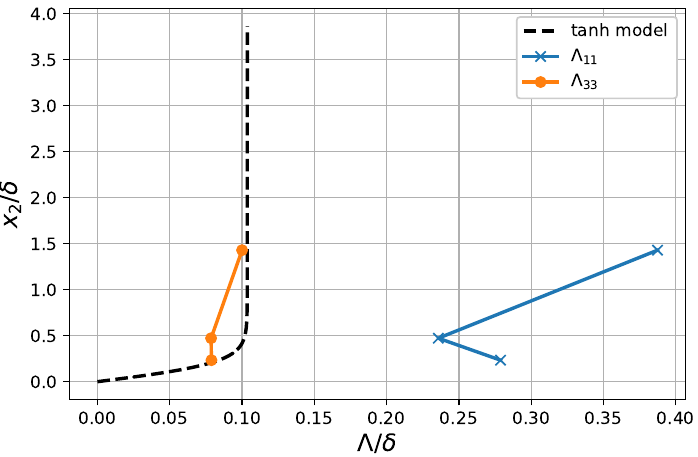
Figure 10. Integral length scale of turbulent structures. Blue: integral of streamwise velocity correla- tion coefficient. Orange: integral of transverse velocity correlation coefficient. Dashed line: hyperbolic tangent model used as a working